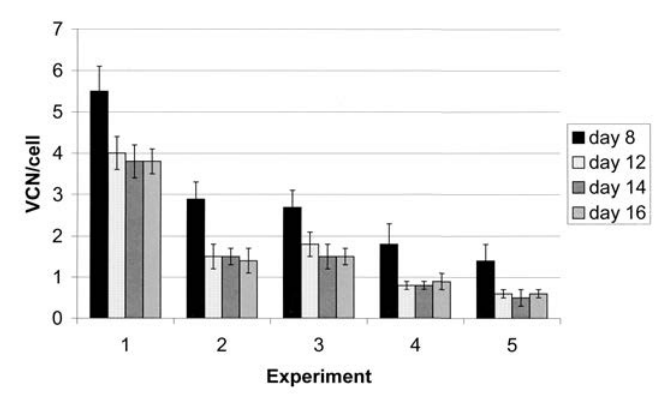
Figure 1. Vector copy number per cell (VCN/cell) analysis in HeLa cells at different time point after transduction with different viral stock preparations. VCN/cell are measured by quantitative polymerase chain reaction in DNA from HeLa cells at day 8, 12, 14 and 16 after transduction with the lentiviral vector-GFP vector. On the ordinate axis is